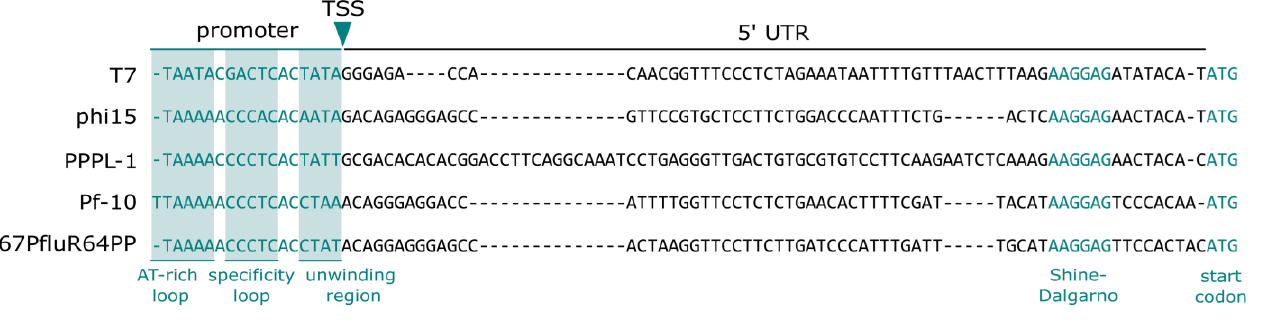
Figure 5. Clustal-omega alignment of the validated promoter and 5′ UTR of the phages’ major capsid protein, separated by the confirmed transcription start site (TSS). Confirmed promoter regions of the T7 promoter and 5′ UTR, namely the AT-rich recognition loop, specificity loop, unwinding region, Shine–Dalgarno sequence, and start codon, are projected on the promoters of the other phages.